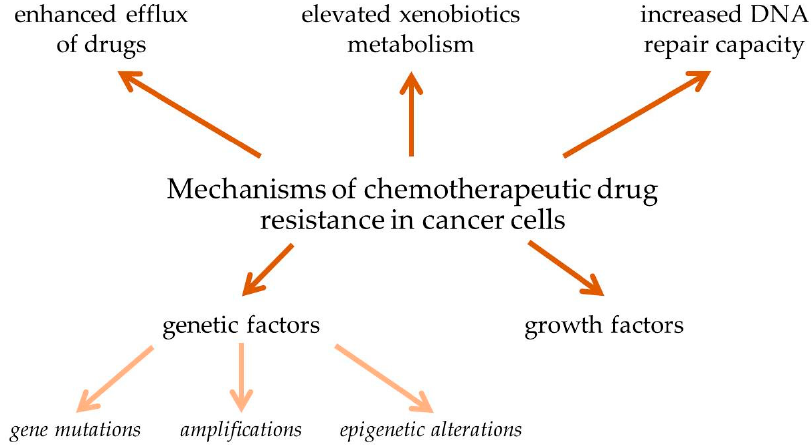
Figure 2. Mechanisms of chemotherapeutic drug resistance in cancer cells